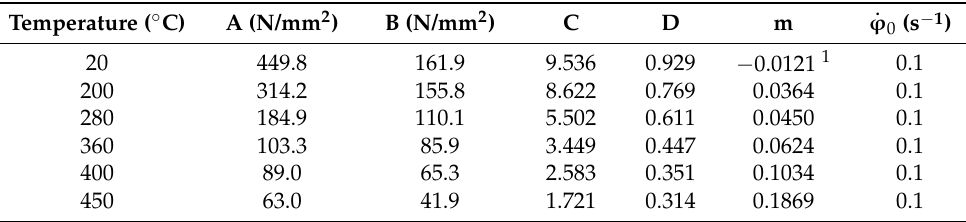
Table 1. Identified values of the flow curve approximation and the strain rate sensitive model.